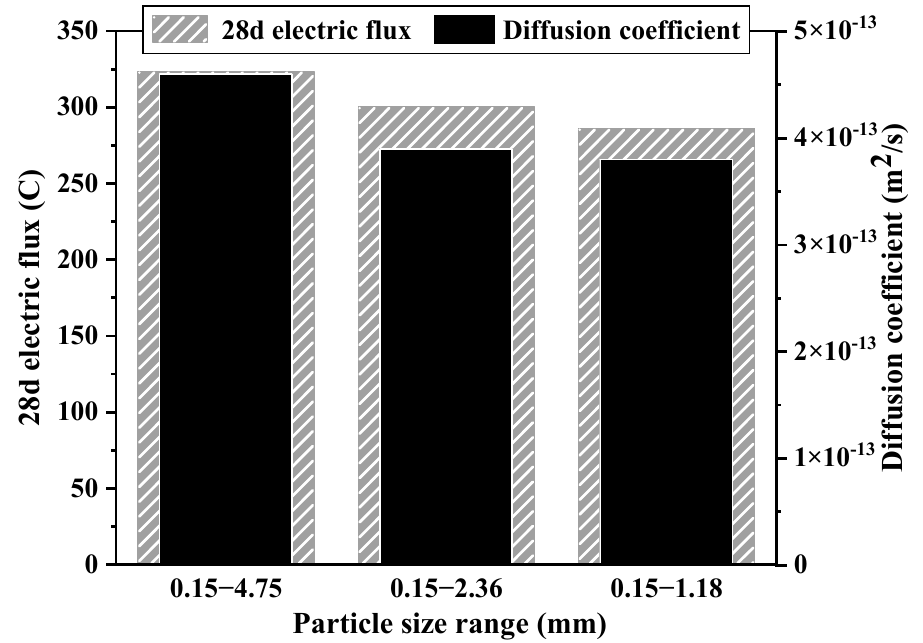
Figure 4. Effect of the LWA particle size on the chloride ion transport properties in L-UHPC.